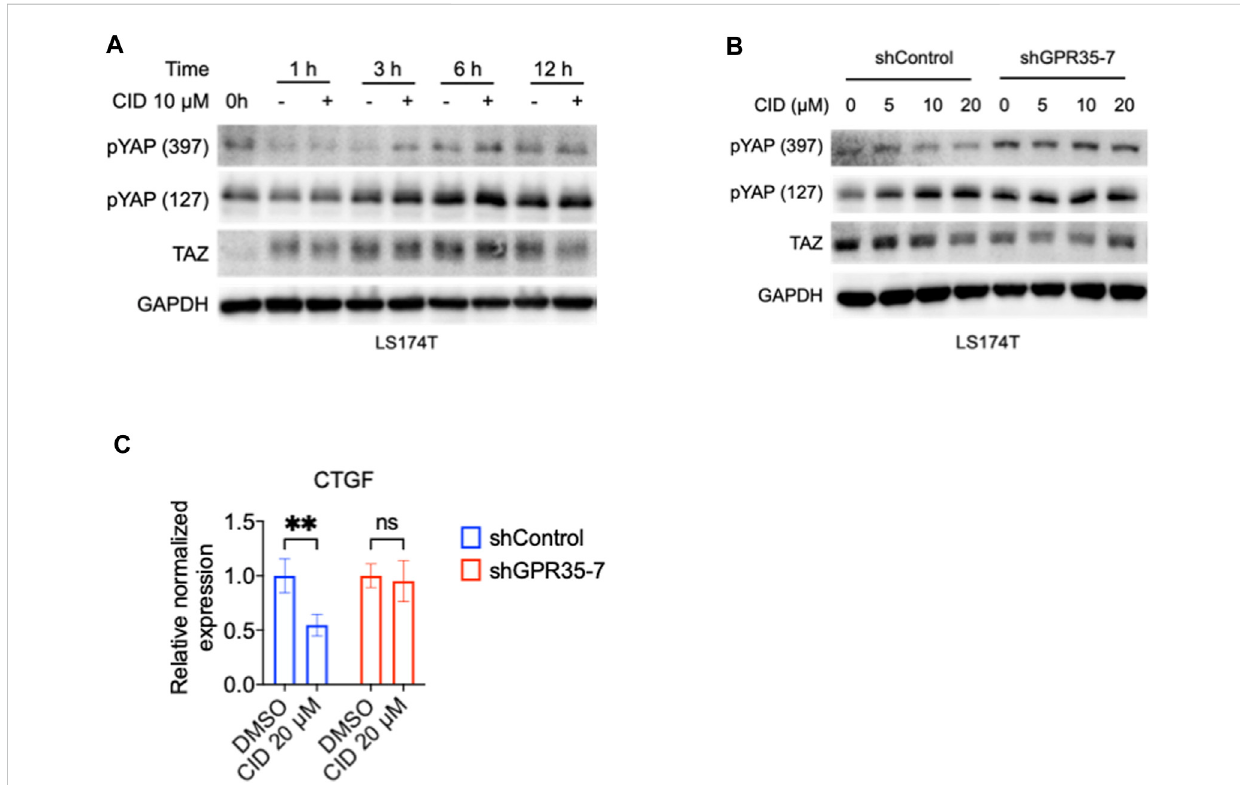
FIGURE 6 GPR35 knock-down attenuatedthe inhibitory effect of CID on YAP/TAZ activity. (A) Westernblot assay on TAZ expression and YAP phosphorylation inLS174Tcells. After24 hofculture,cells weresubjecttoafreshmedium containing10%FBSwithorwithoutCID fortheindicatedtime. (B) Westernblot assay on TAZ expression and YAP phosphorylation in shControl and shGPR35-7 LS174T cells. After 24 h of culture, cells were subject to a fresh medium containing 10% FBS with or without CID for 3 h (C) mRNA expression of CTGF. Cells were harvested for analysis after 12 h of